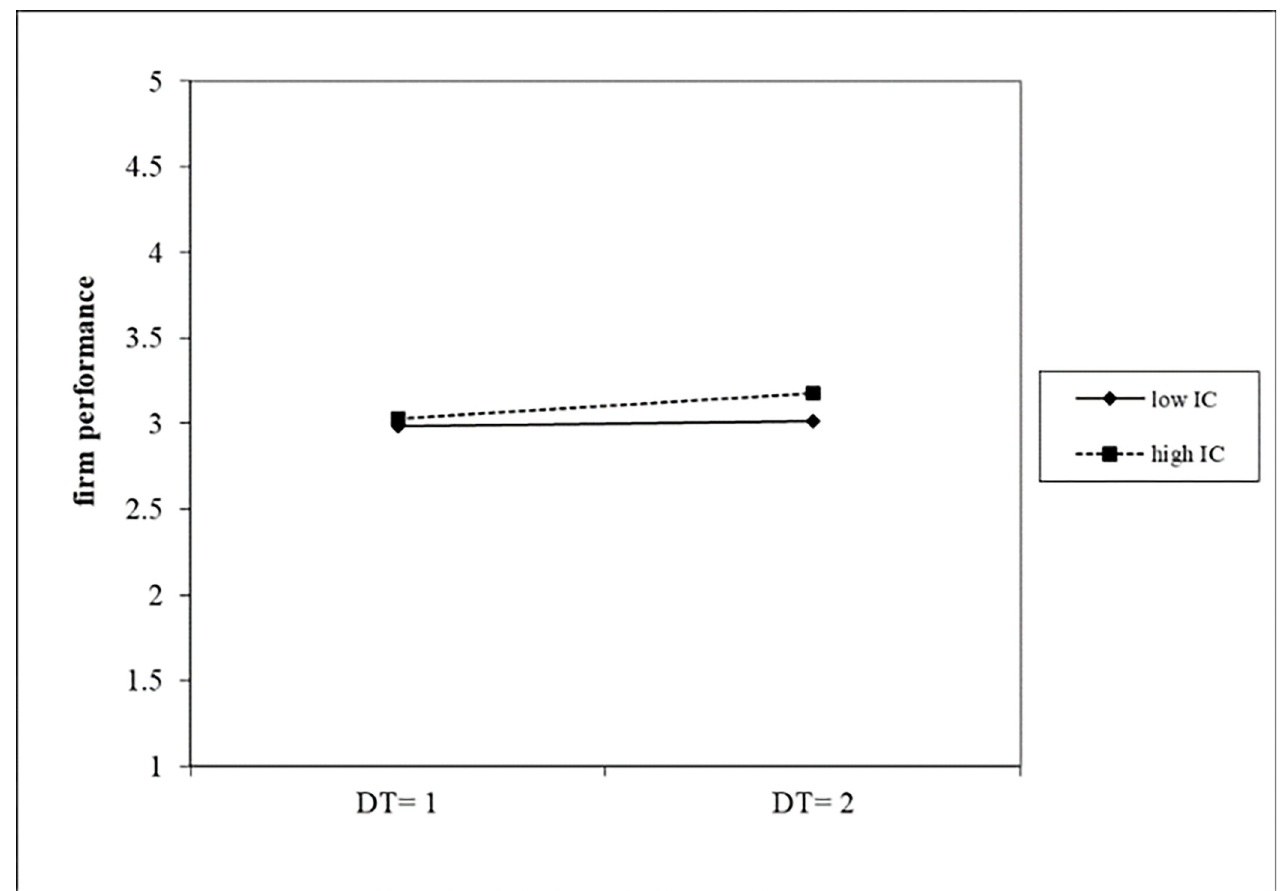
Fig 4. The moderating effect of innovation capability on firm